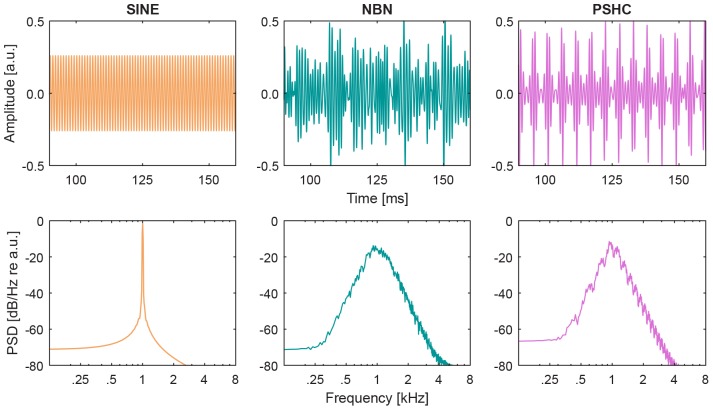
Stimulus waveforms (upper panels) and power spectrum densities (PSD, lower panels) are shown for each acoustic stimulus type: sinusoid (SINE), narrow-band noise (NBN), and pulse spreading harmonic complex (PSHC), all centered at 1 kHz.